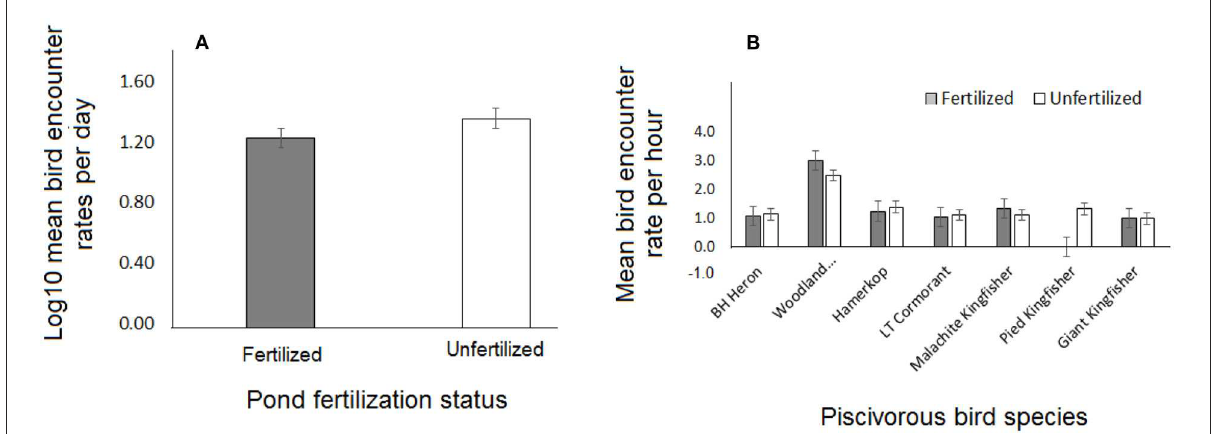
FIGURE1 Effect of pond fertilization on encounter rates (A) Per diurnal day for piscivorous birds in general, and (B) Per diurnal hour for each species. BH Heron = Black-headed Heron; Woodland = Woodland Kingfisher; LT Cormorant = Long-tailed Cormorant.